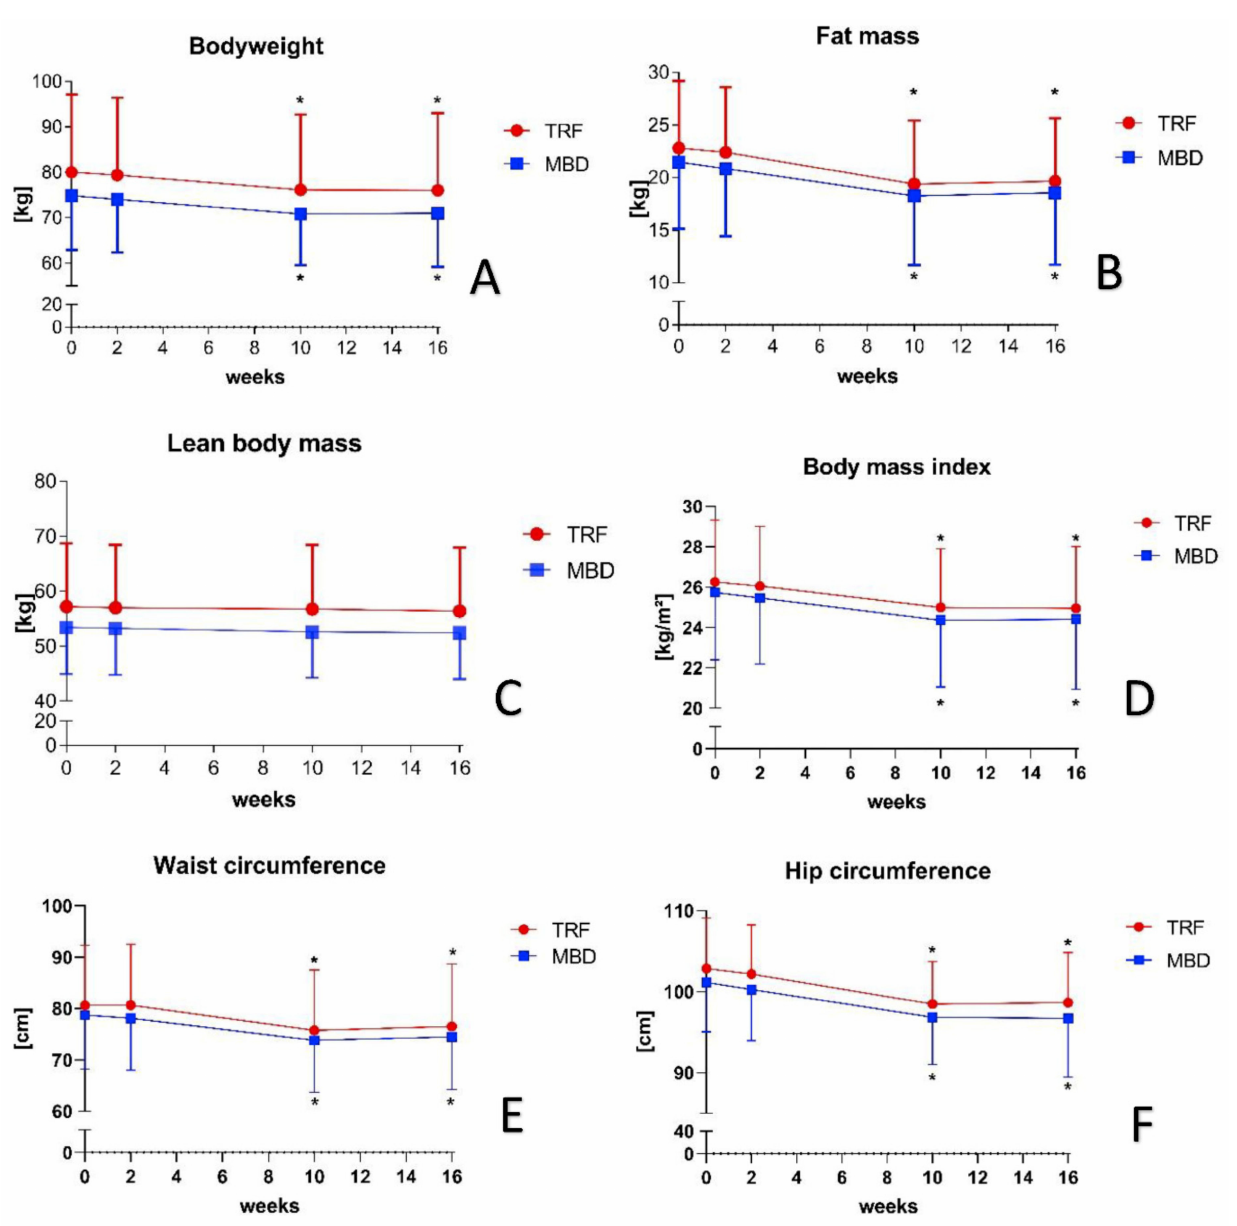
Figure 3. Changes in body composition in the TRF and MBD group (( A ) body weight; ( B ) fat mass; ( C ) lean body mass; ( D ) body mass index; ( E ) waist circumference; ( F ) hip circumference). Significant differences were set with p < 0.05 and marked with * for time differences to T0. Abbreviations: MBD = macronutrient-based diet; TRF = time-restricted